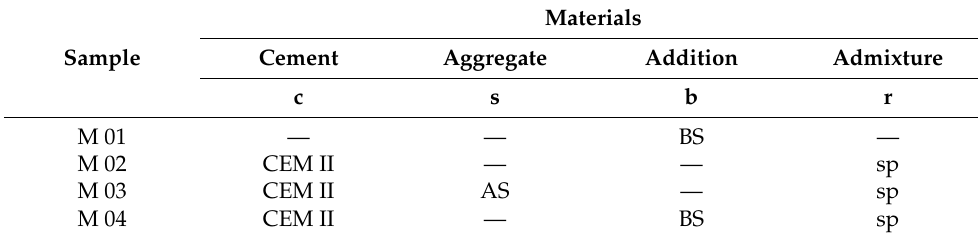
Table 2. Materials used in M 01, M 02, M 03 and M 04.